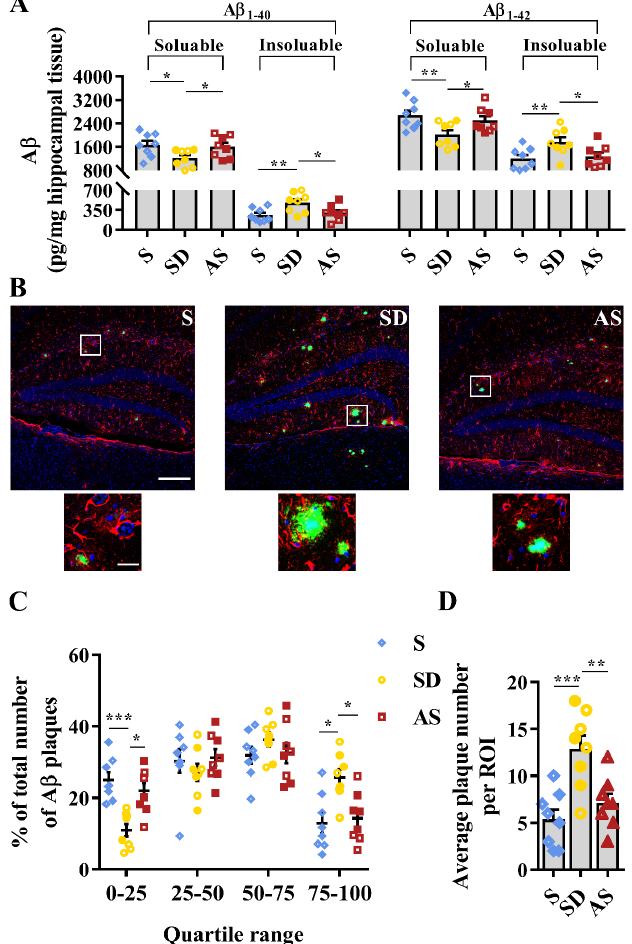
Figure 5. Acoustic stimulation reversed A β pathology. ( A ), Soluble and insoluble A β 1–40 and A β 1–42 levels in hippocampal tissue. ( B ) Representative immunofluorescence images of astrocytes (red), A β plaques (green) and nuclei (blue) in the dentate gyrus area. Scale bar, 200 µ m; scale bar of insets, 20 µ m. ( C ) A β plaques were ranked and divided into quartiles according to their diameter (the Kruskal–Wallis test followed by the Mann–Whitney U test with Bonferroni-corrected p values). ( D ) Quantitative analysis of the number of A β plaques. One-way ANOVA followed by two-sample LSD t tests is used. Data are expressed as mean ± SEM. Closed dots constitute male mice, and open dots constitute female mice. * p < 0.05, ** p < 0.01, *** p <